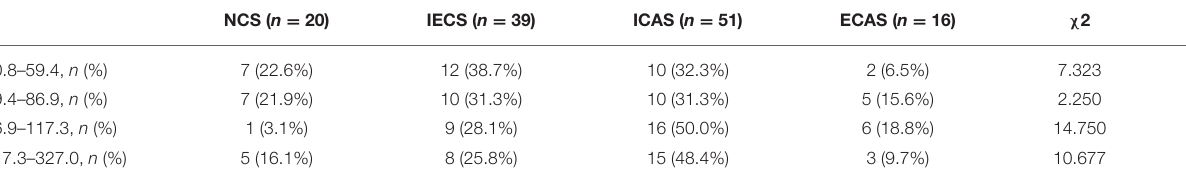
TABLE 4 | Percentage distribution of stenosis subtypes among the four quartiles of lipoprotein-associated phospholipase A2 (Lp-PLA2).